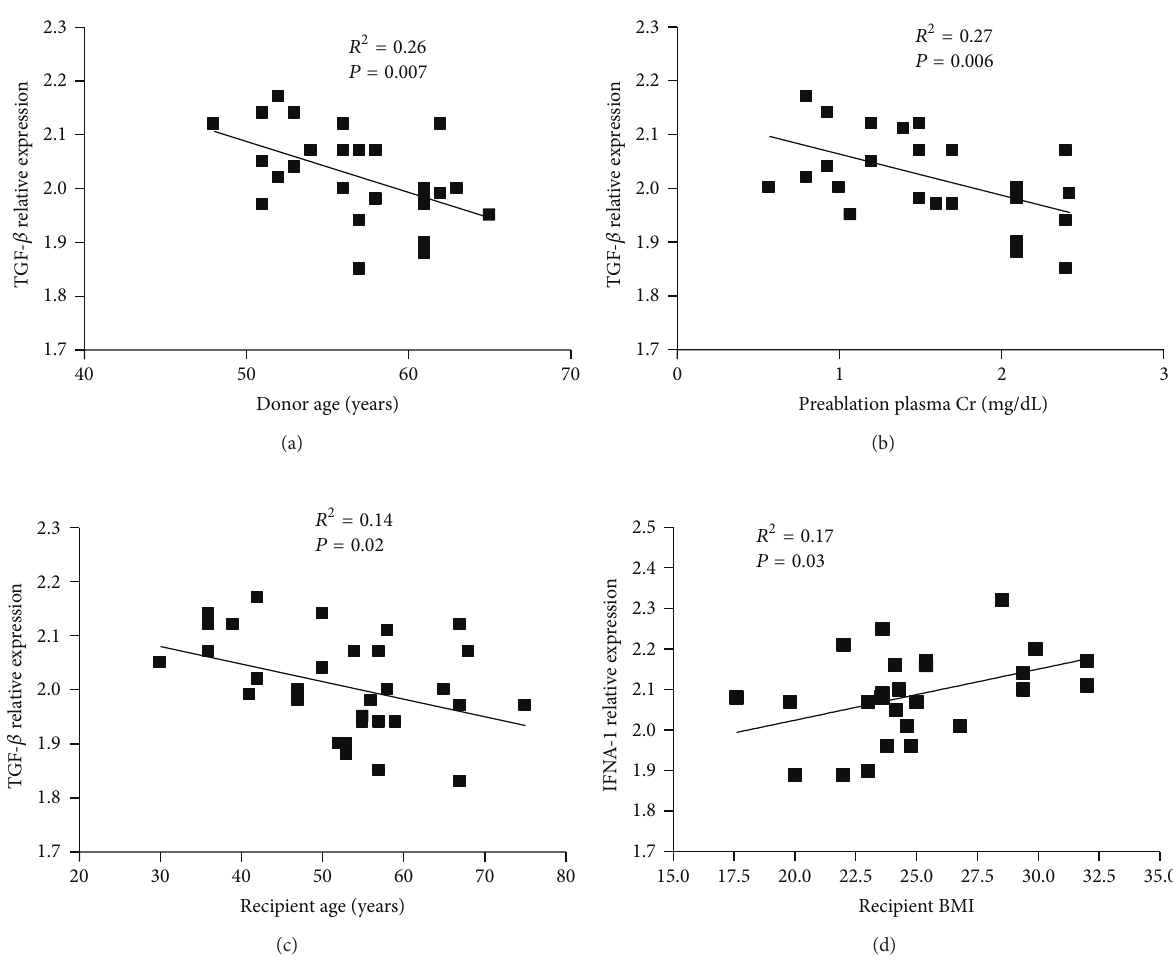
Figure 3: Correlation between the gene expression levels and recipient and donor risk factors. Correlation between donor age and TGF- 𝛽 (a), preablation creatinine and TGF- 𝛽 (b), recipient age and TGF- 𝛽 (c), and recipient BMI and IFNA-1 (d). Regression lines are shown in each figure with correlation coefficients ( 𝑅 2 ) and 𝑃